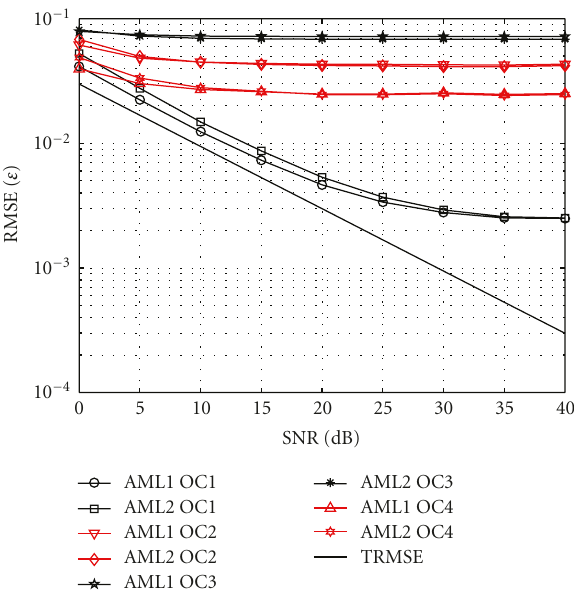
Figure 1: Performance of the proposed AML CFO estimators in AWGN channel.